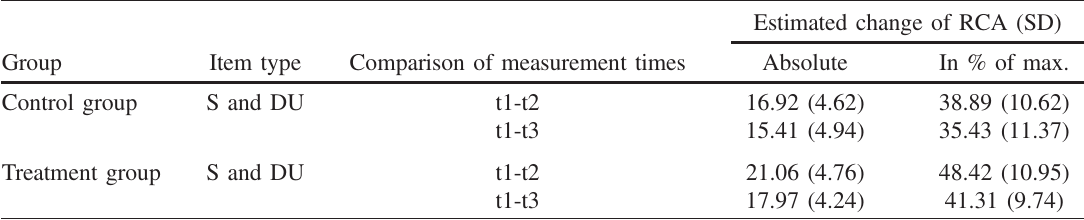
TABLE IV. Estimated changes of RCA between pre- and post-test, and pre- and follow-up test (multilevel model for measuring changes).